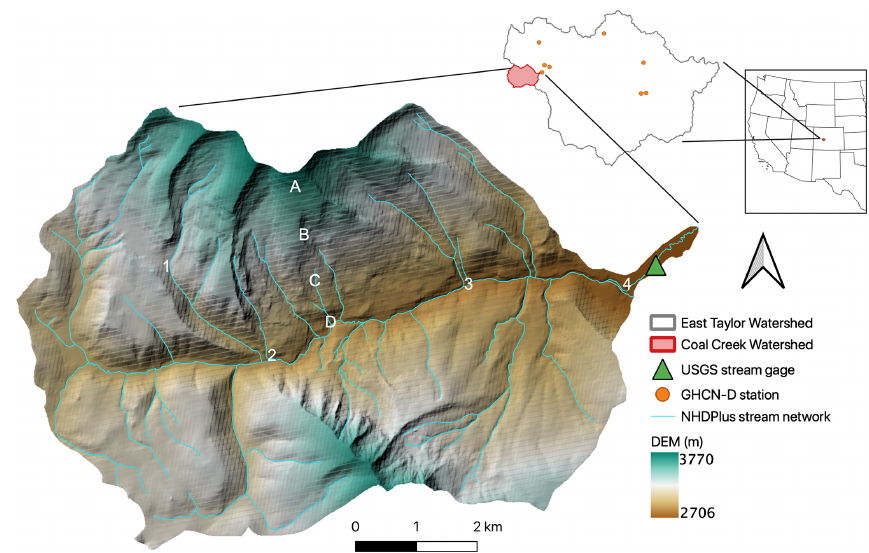
Figure 1. Map of the Coal Creek Watershed in relation to the larger East Taylor Watershed as well as its relative location in the western US. Also shown are the locations of GHCN-D stations, the USGS stream gage, the National Hydrography Dataset Plus (NHDPlus) stream network, and the digital elevation model (DEM). The marked points (A–D) and (1)–(4) are point locations used to observe groundwater table and surface ponded depth from the model,